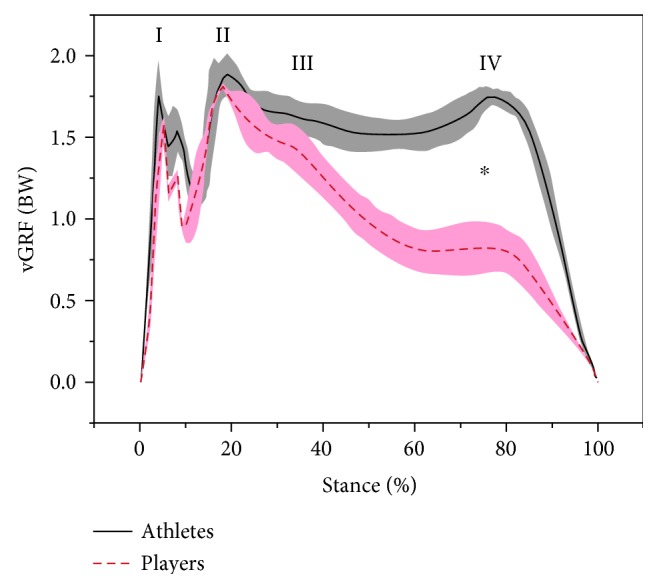
The illustration of mean vertical ground reaction force (vGRF) (with standard deviation) pattern of badminton players in the stance of lunge (I, II, III, and IV, resp., indicate the initial impact peak, secondary impact peak, weight acceptance, and drive-off phases; ∗ indicates significant difference at p < 0.05).